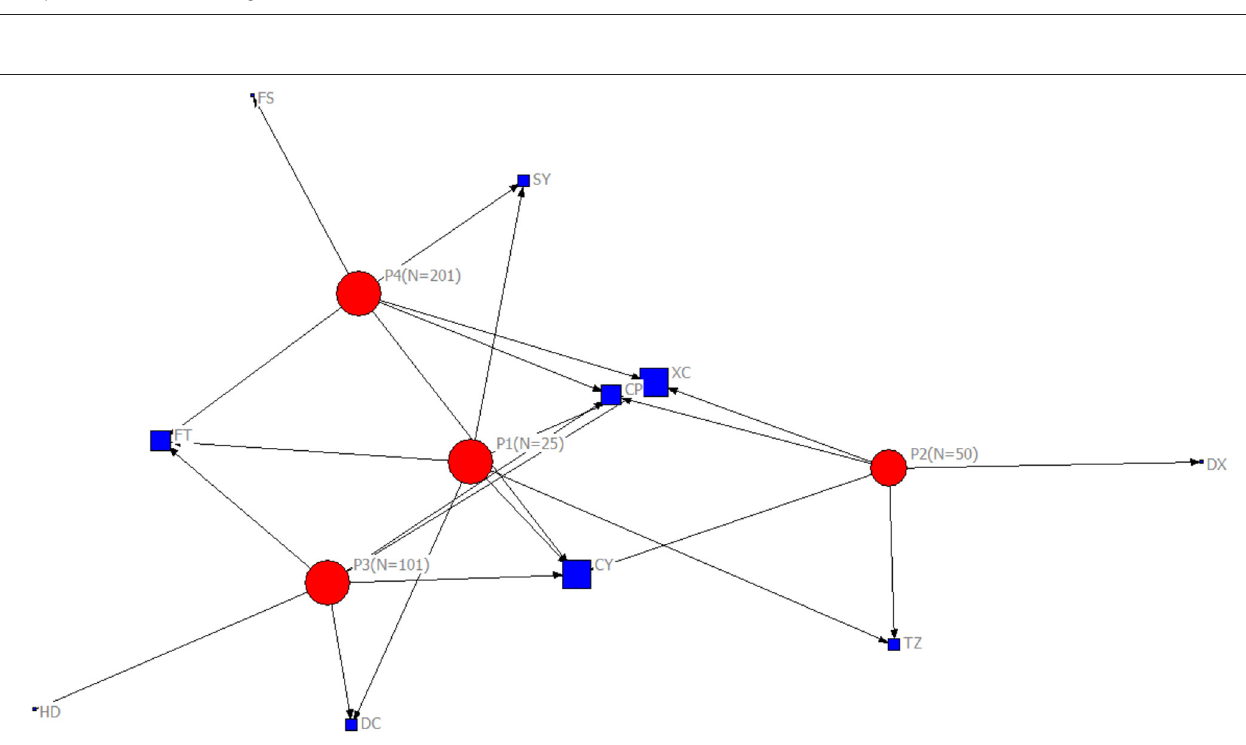
FIGURE 10 | (A) Immune Performance for Key Node Analysis based on a Immune Algorithm in Case 1. (B) Immune Performance for Key Node Analysis based on a Immune Algorithm in Case 2. (C) Immune Performance for Key Node Analysis based on a Immune Algorithm in Case 3. (D) Immune Performance for Key Node Analysis based on a Immune Algorithm in Case 4.